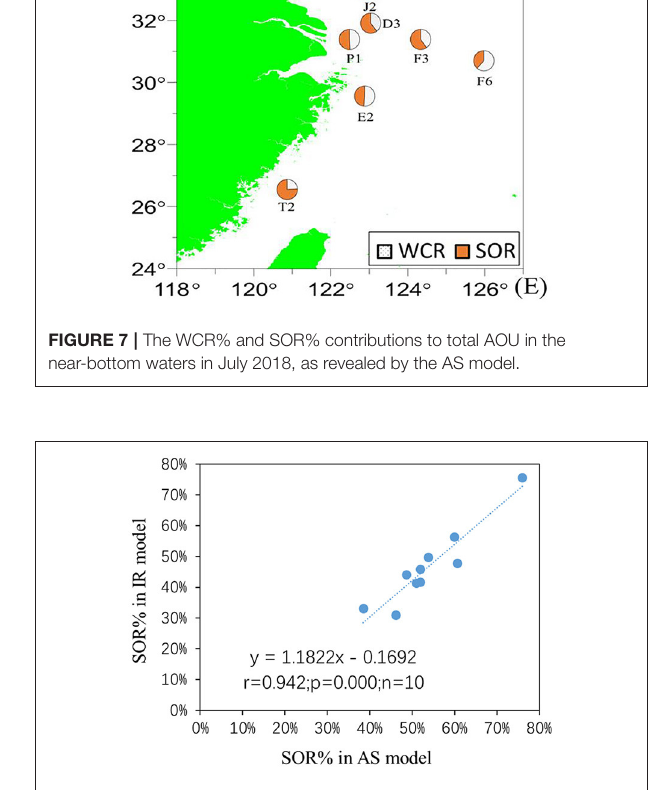
FIGURE 8 | The SOR% contribution to the total AOU based on both models: AS model result vs. IR model